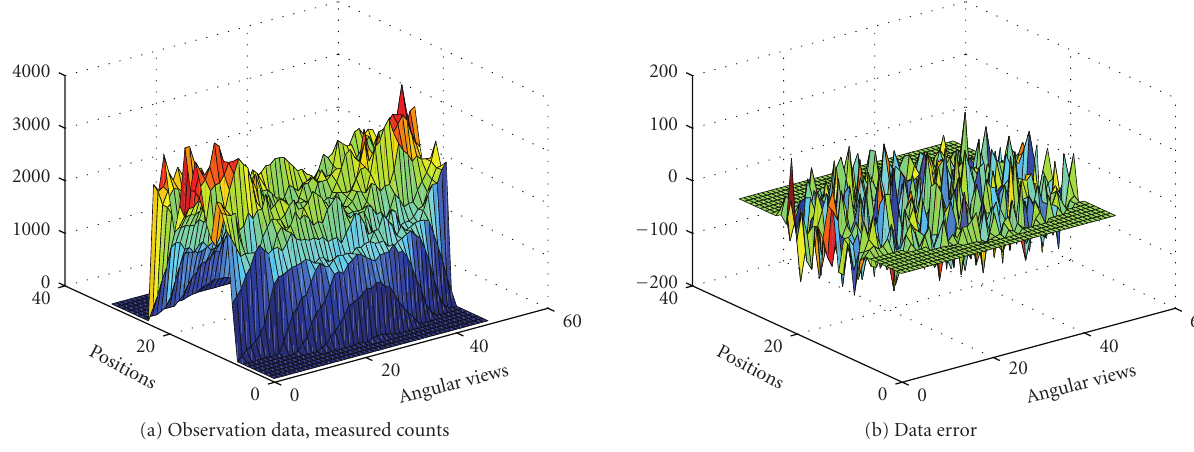
Figure 6: Sinogram data, obtained by forward projection: n = Pλ plus Poisson